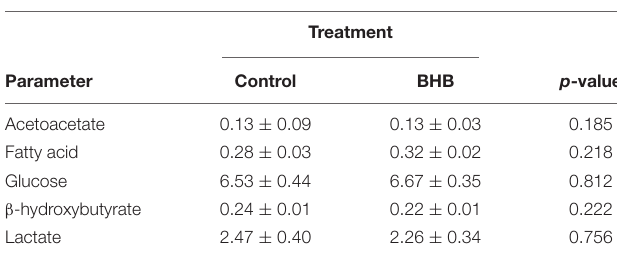
TABLE 2 | Levels of metabolites (mM) in plasma of rainbow trout 6 h after intracerebroventricular administration of 1 µ L 100 g − 1 body mass of